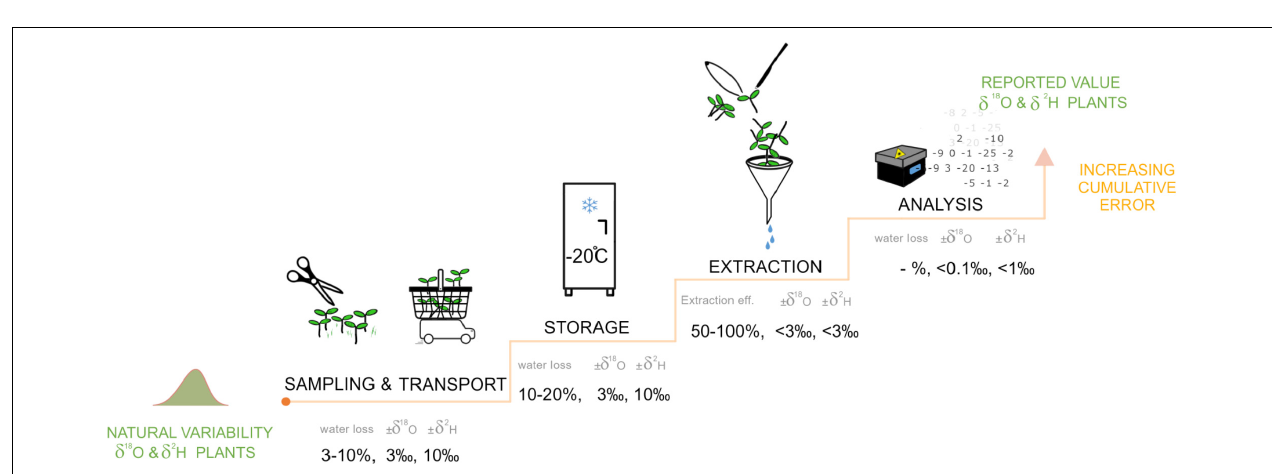
FIGURE 4 | The process chain from plant sample collection and transport, storage, plant water extraction and isotope analysis to the final isotope composition. At each step, the potential water loss and associated error in isotopic composition for δ 18 O and δ 2 H are indicated as % and cumulative error in the isotope composition increases, highlighting the importance to focus not only on the extraction technique but on the full process chain.